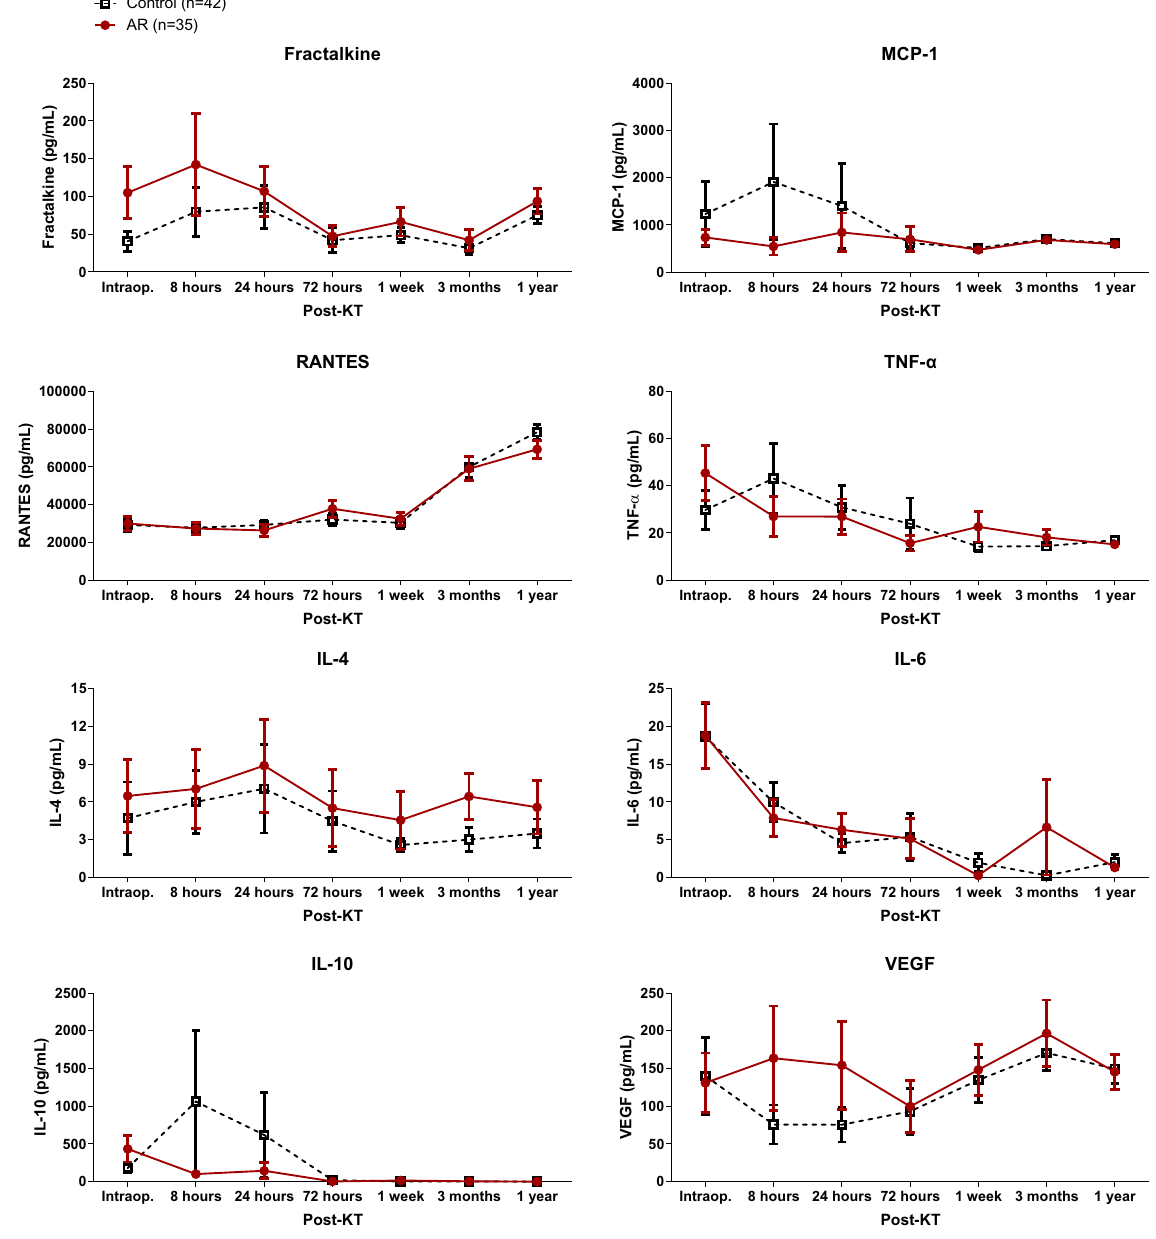
Figure 3. Serial changes in serum cytokines/chemokines of the control and AR groups. Serum cytokines/ chemokines were comparable in the control and AR groups at each time point for the first year after KT. AR acute rejection, MCP-1 monocyte chemoattractant protein-1, IL interleukin, KT kidney transplantation, RANTES regulated on activation, normal T cell expressed and secreted, TNF-α tumor necrosis factor-α, VEGF vascular endothelial growth